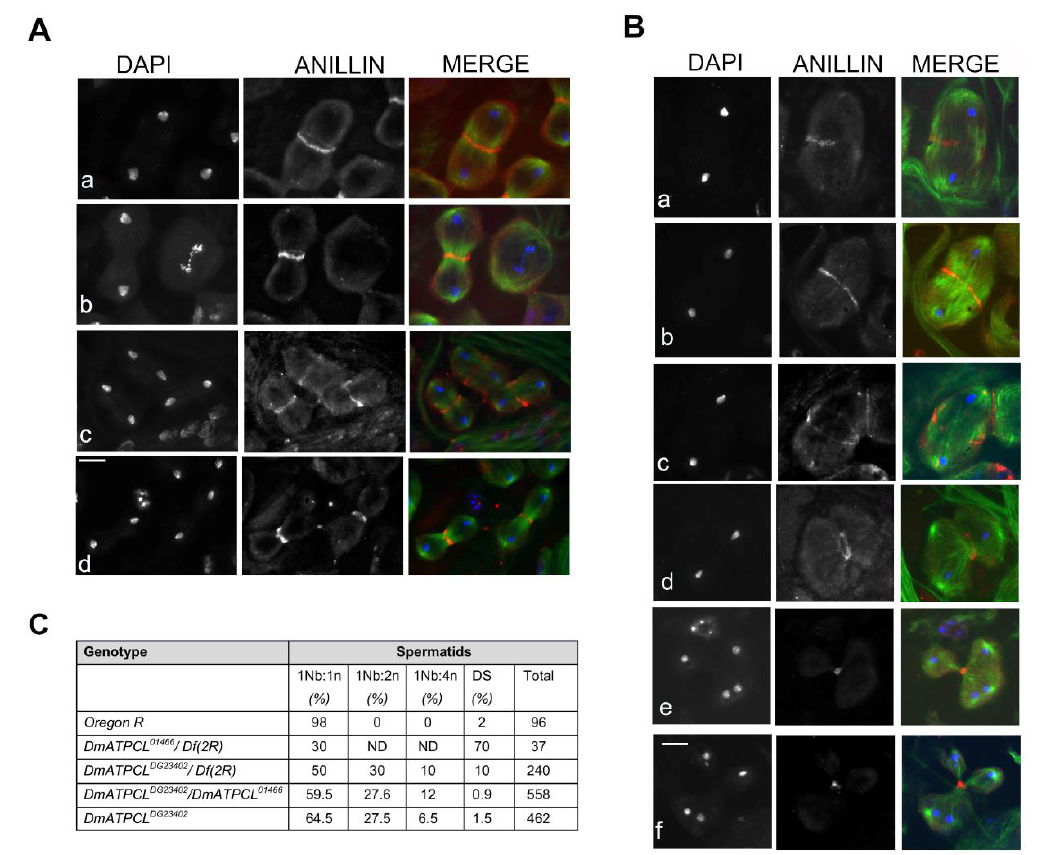
Figure 2. Depletion of DmATPCL impairs cytokinesis. Anti-anillin (red) and anti-tubulin (green) immunostaining in control ( A ) and DmATPCL DG23402 mutant allele ( B ). DNA is counterstained with DAPI. Note that in wild-type testes anillin starts to concentrate in a ring-shape configuration at the cell equator of dividing spermatocytes during anaphase and constricts during cytokinesis in telophase during both first ( Aa , b ) and second ( Ac , d ) meiotic divisions. In contrast, DmATPCL DG23402 mutant testes display cells with unconstrained central spindles during ana-telophase I ( Ba – c ) in which anillin localizes at the central spindle to eventually form a contractile ring that appeared fuzzy ( Ba ), remained unconstrained ( Bb ), and degenerates ( Bc ). In ana-telophase I cells with multipolar spindles ( Bd – f ) anillin still localizes at the equator of cells and participates to the formation of one single contractile ring that eventually completed cytokinesis, ultimately giving rise to irregular spermatids. Bar = 10 μm. ( C ) Frequency of irregular spermatids from different DmATPCL mutant combinations. 1Nb:1n = normal “onion stage” spermatids; 1Nb:2n = “Onion stage” spermatids with 1 large nebenkern (Nb) associated to 2 haploid nuclei (n); 1Nb:4n = “Onion stage” spermatids with 1 large Nb associated to 4 haploid nuclei; DS = Spermatids with di ff erent-sized nuclei; Df(2R) = Df(2R)Exel7138